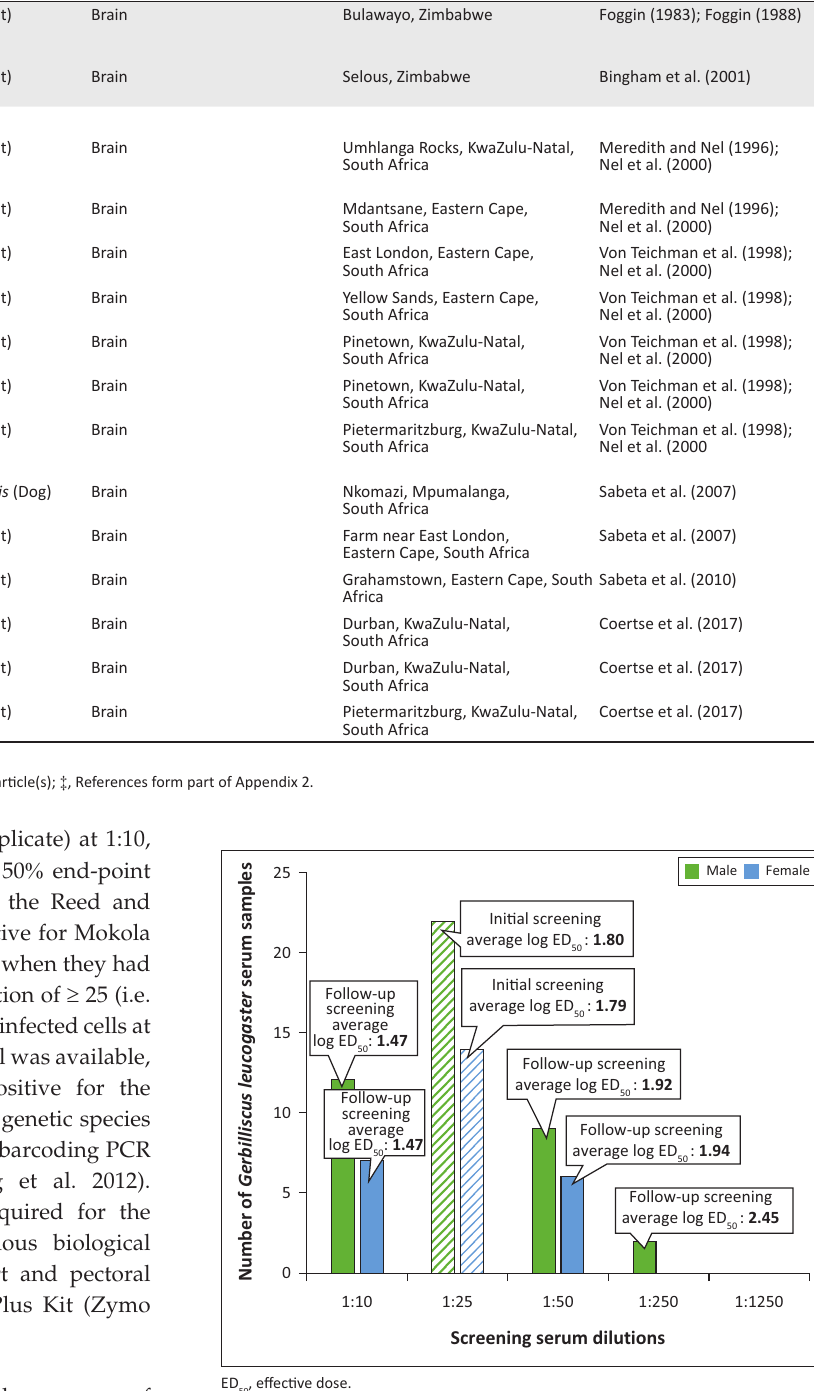
Follow-up screening